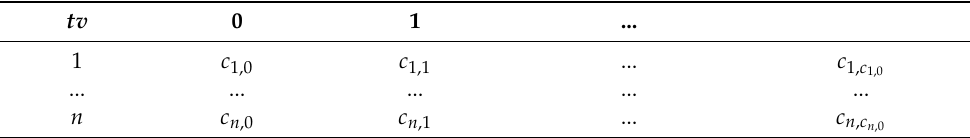
Table A1. Primary molecular topology